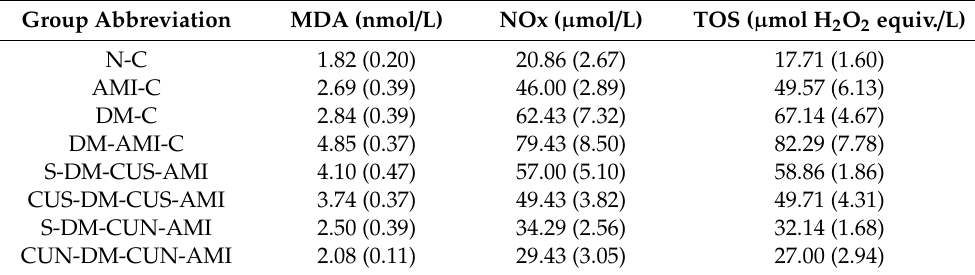
Table 5. Serum levels oxidative stress